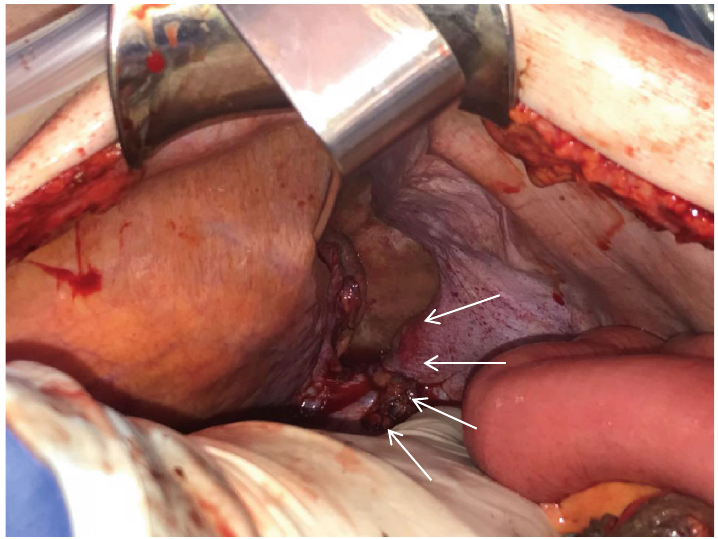
Figure 3: Intraoperative picture. Arrows indicating diaphragmatic